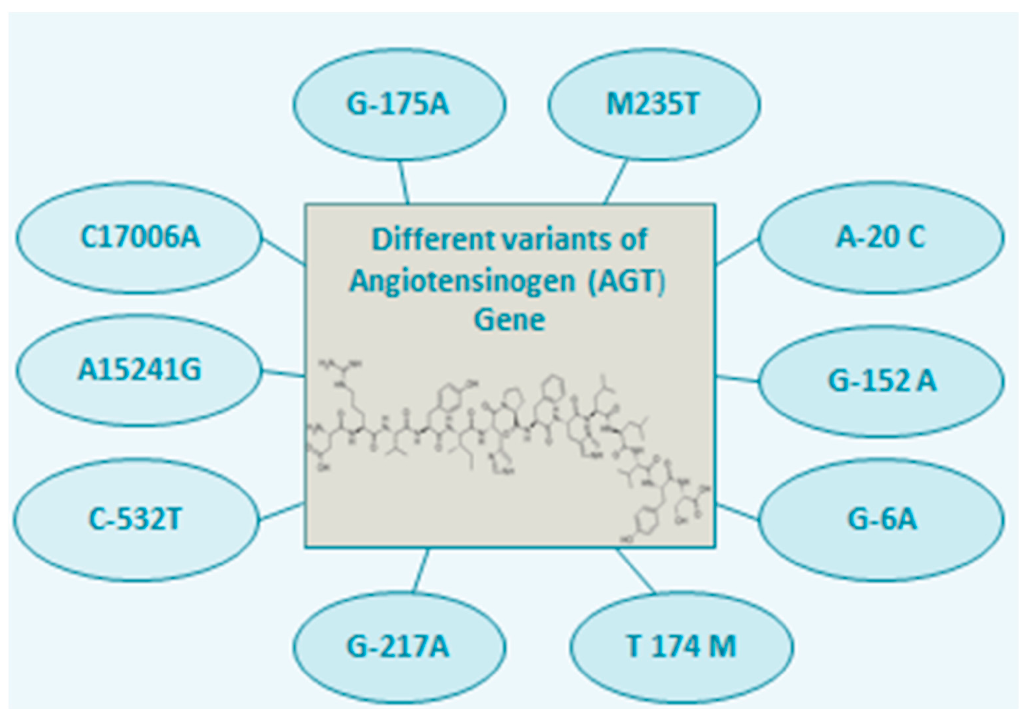
Figure 2. Graphical representation of different variants of the AGT gene that are linked to various diseases. AGT M235T (rs699) and T174M (rs4762) are the two most common and significant